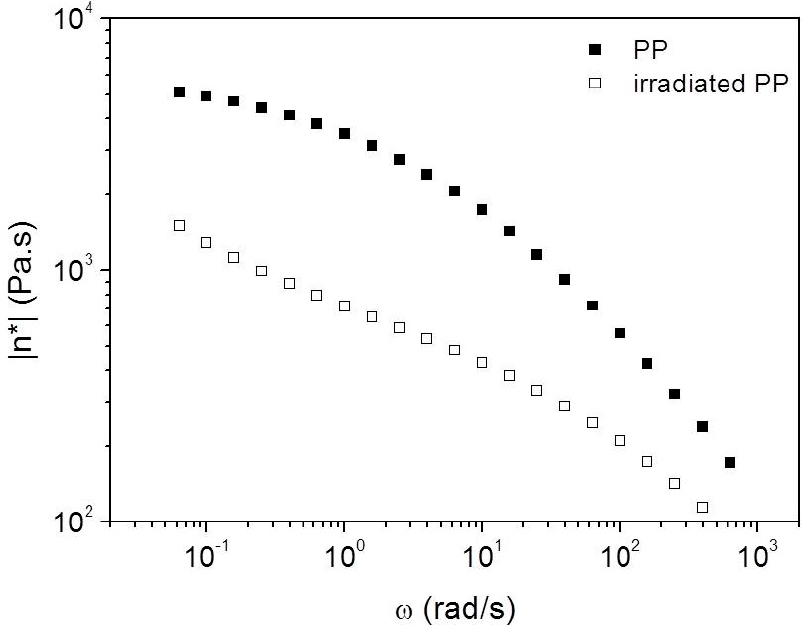
Figure 4. Comparison of the complex viscosity of pure PP before and after irradiation at 80 kGy. The irradiated sample shows shear thinning (concavity) behavior at low frequencies .